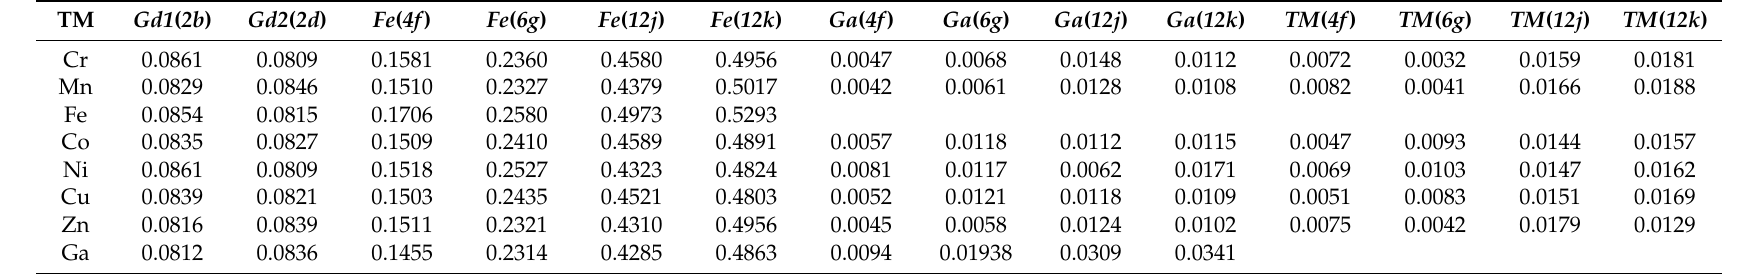
Table 2. Atomic site occupancy derived from Rietveld refinement for Gd 2 Fe 17 and Gd 2 Fe 16 Ga 0.5 TM 0.5 (TM = Cr, Mn, Co, Ni, Cu, Zn, and